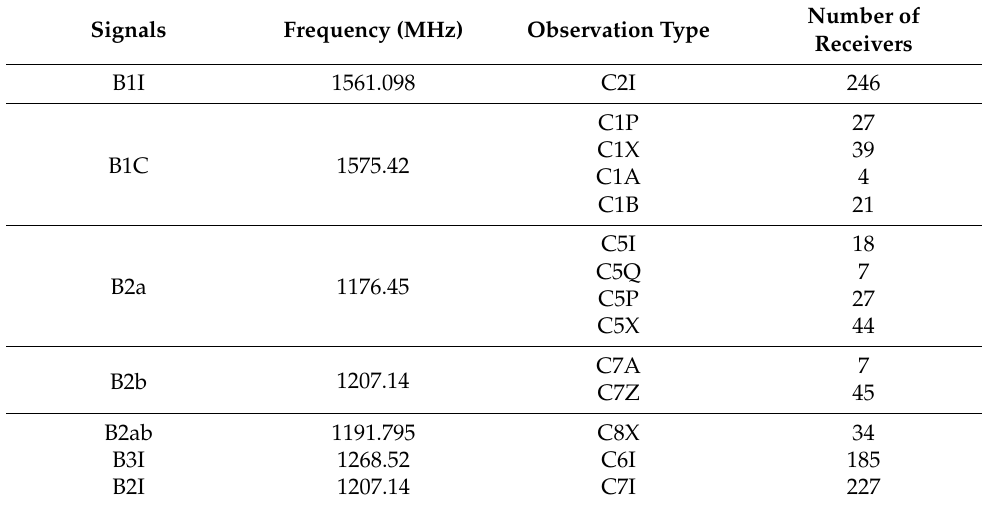
Table 4. Information on receiver types and antenna types used for the METG, SPT0 and YAR2 stations.